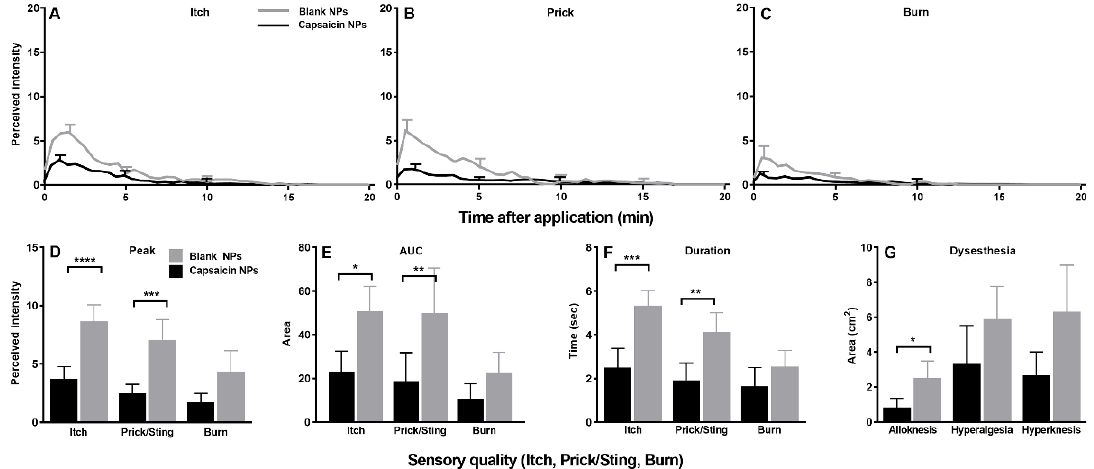
Figure 9. Effects of capsaicin NP pretreatment on sensations and dysesthesias evoked by BAM8-22 spicules. ( A – C ) Time course of perceived intensities of itch, pricking/stinging, and burning. Same format as Figure 7. ( D ) Peak magnitude (Peak) of each sensory quality. ( E ) Area under the rating curve (AUC). ( F ) Duration of response. ( G ) Area of each type of dysesthesia: alloknesis, hyperalgesia and hyperknesis. n = 21, ( A – C ) repeated measures two-way ANOVA; two repeated treatment groups (capsaicin vs. placebo treatment) × 40 repeated timepoints (0–20 min) with Bonferroni cor- rection, ( D – G ) Wilcoxon test. Data are means with SEMs. * p < 0.05, ** p < 0.01, *** p < 0.001 and **** p < 0.0001.